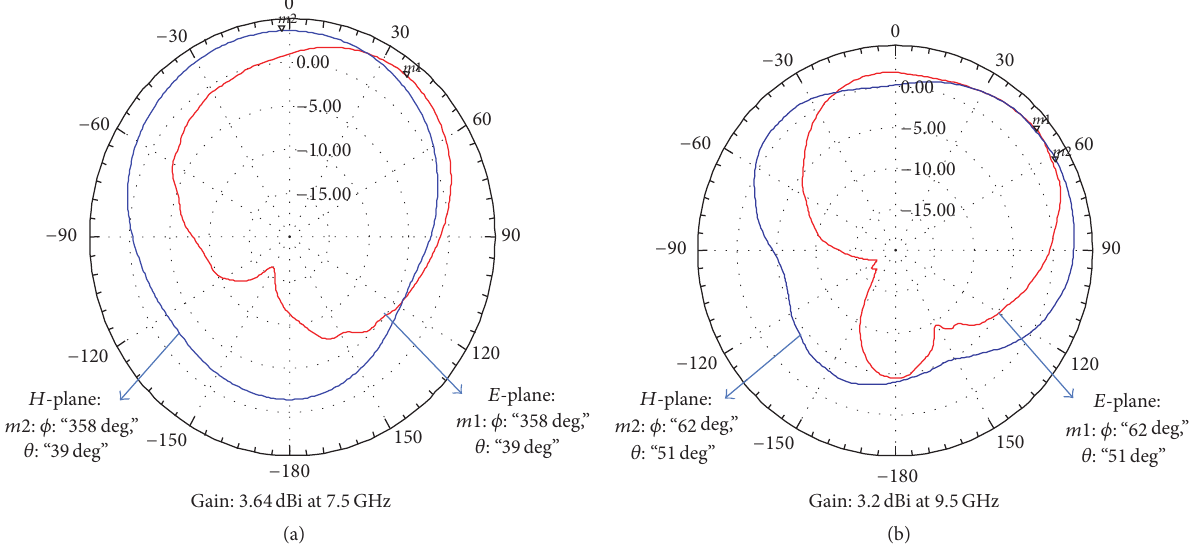
Figure 23: 2D radiation patterns of the NB antenna at (a) 7.5GHz and (b) 9.5 GHz.